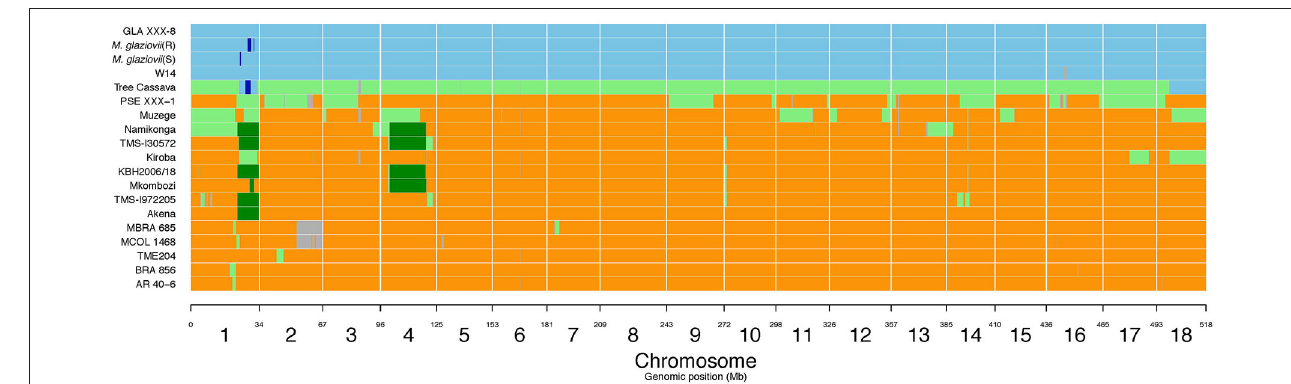
FIGURE 5 | M. glaziovii introgression segments in selected cassava genotypes, including Kiroba and Namikonga, and based on whole genome sequence data. Orange indicates M. esculenta genotype; blue indicates M. glaziovii , light green represents hybrid M. esculenta and M. glaziovii , dark green indicates the presence of a shared haplotype proposed to be inherited from the Amani program (modified from Bredeson et al., 2016; Permission for the modification and publication of the adapted figure has been obtained from the copyright holder).